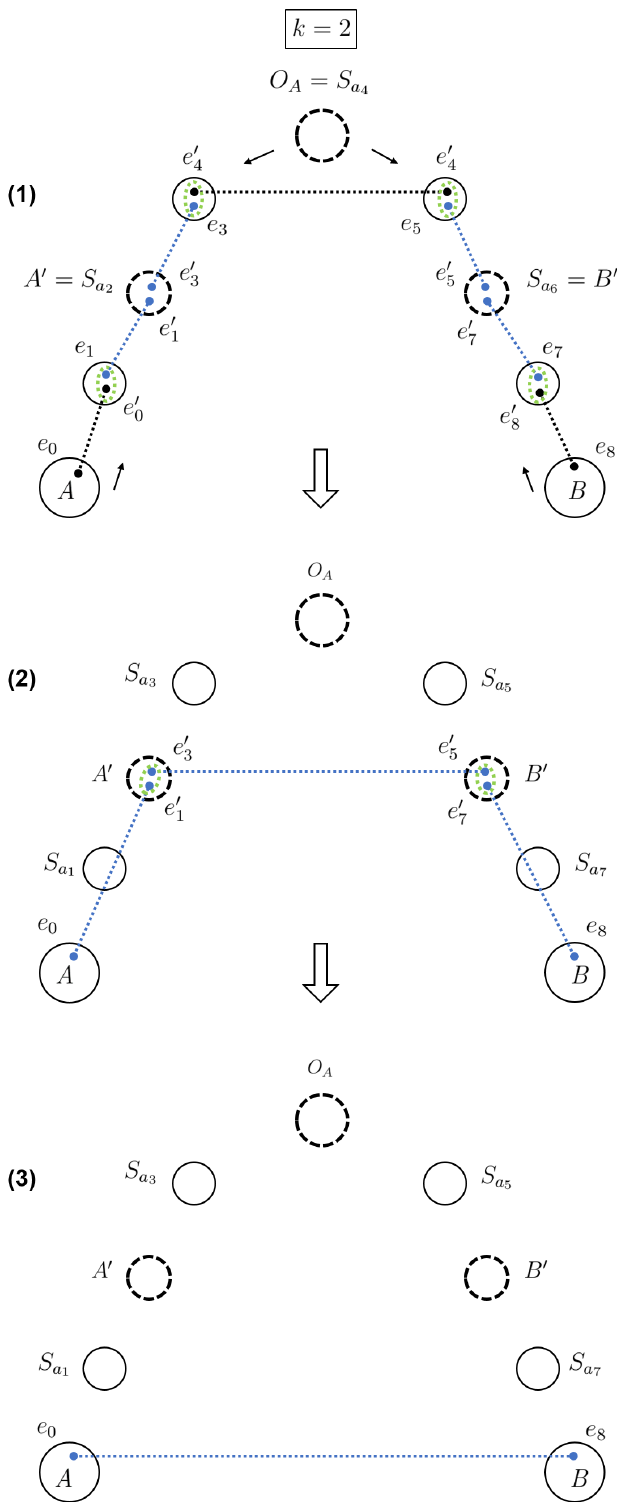
Figure 7. Example for k = 2. Nodes A (cid:48) and B (cid:48) can no longer be reached directly by A , B or O A . Links of entangled pairs are established according to the instructions received by each node. Without needing to be synchronized, Bell measurements are performed at each station on the four segments of the path (1). Middle nodes A (cid:48) and B (cid:48) can execute the same task after receiving the qubits from their adjacent nodes (2), thus providing A and B with entangled pair of particles e 0 and e 8